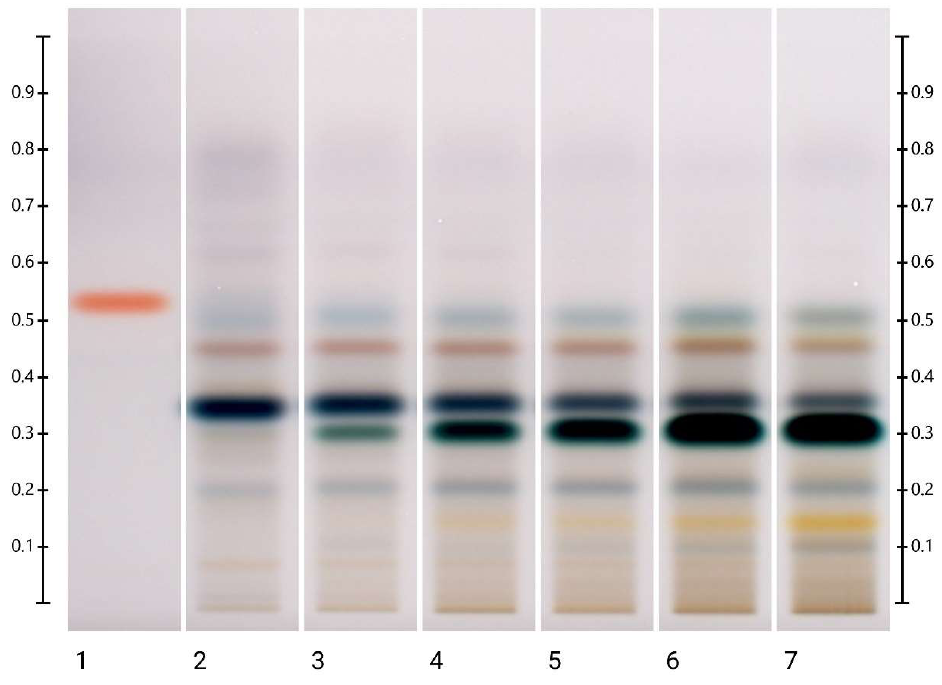
Figure 5. PEP long-term storage at 60 °C. Images taken under white light after derivatisation with vanillin reagent; Track 1—4,5,7-trihydroxyflavanon, Track 2—0 h, Track 3—1 month, Track 4—2 months, Track 5—3 months, Track 6—4 months, and Track 7—5 months; 5 μL of each honey ex- tract, respectively. Table 2. Effect of temperature on the HPTLC fingerprints of the honeys.